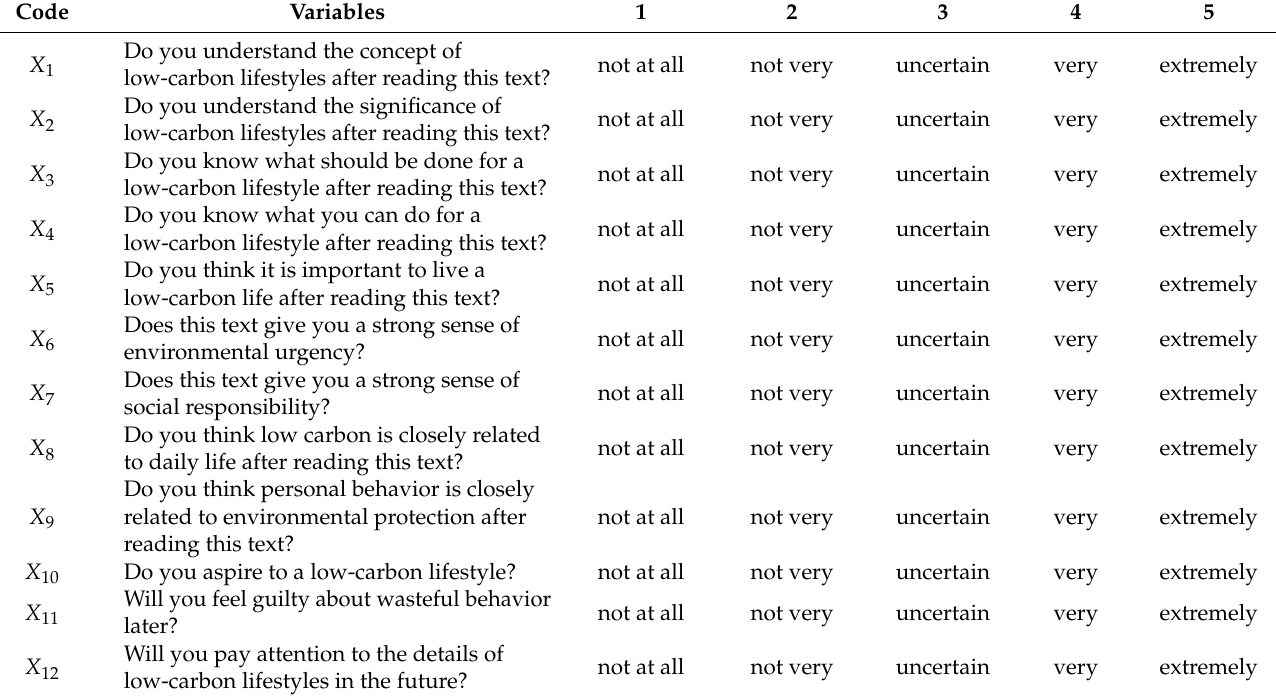
Table 1. Items for factor